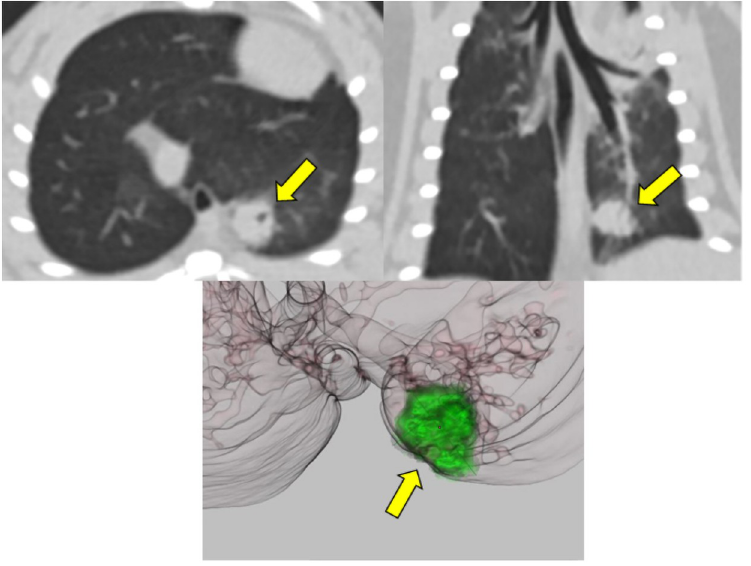
Fig 4. Conventional chest CT images with axial and coronal reconstruction of squamous cell carcinoma from rat #1 show a mass in the left lower region (upper panel, arrows). The nodule shows a spiculated border and bubbly appearance. These CT findings are similar to lung cancer found in humans. The volume of this squamous cell carcinoma in the 3D reconstructed image was 0.079 mm 3 , and the longest diameter was 7 mm (lower panel, arrow).